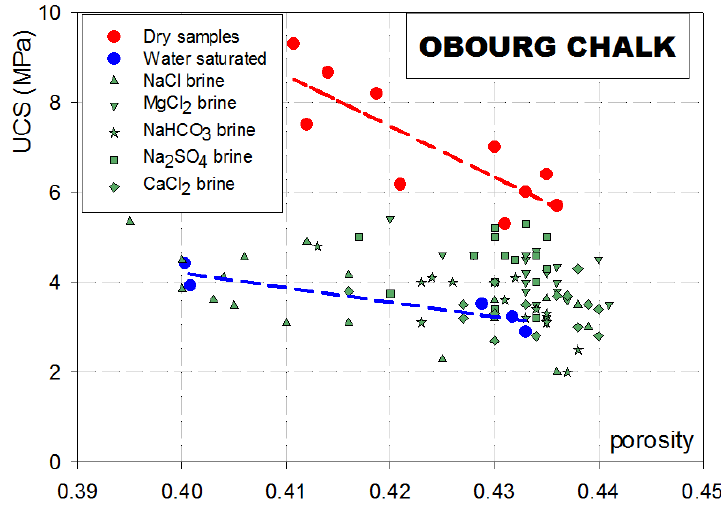
Figure 8. UCS values for the Obourg chalk vs. porosity for 100 samples with different fluid content.